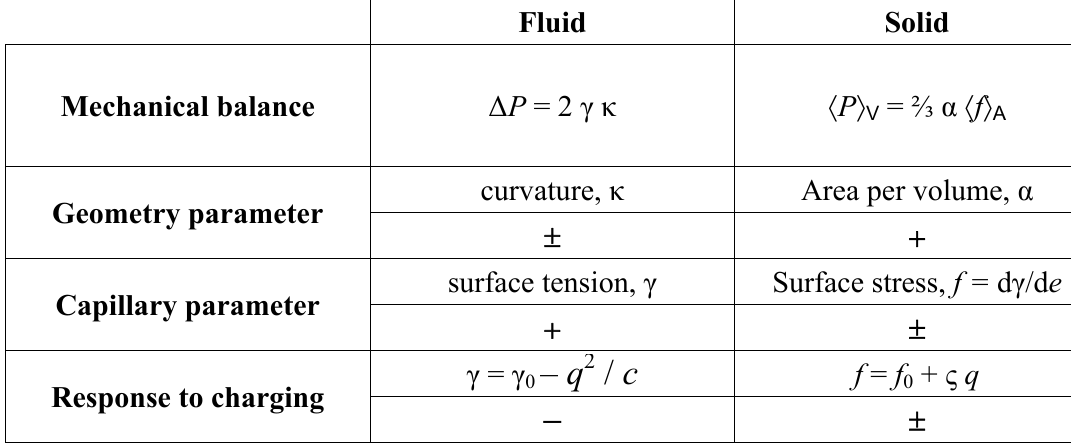
Table 1. Results for electrocapillary pressure in fluids and solids. The pressure that is exploited in the electrochemical actuation of nanoporous metals is described by the equations and parameters in the column to the right. Note the fundamental difference to the Laplace pressure in fluid droplets, central column. The restrictions on the sign of the individual parameters, indicated in the table, emphasize these differences. Symbols are defined in the main text. For a detailed discussion see Ref.